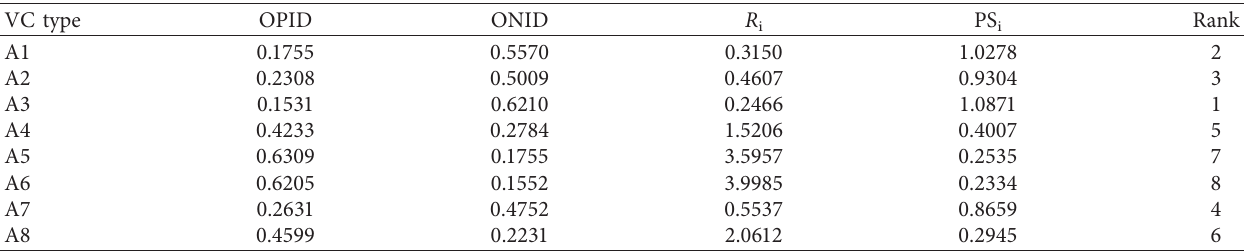
Table 14: Ranking of the VCs.